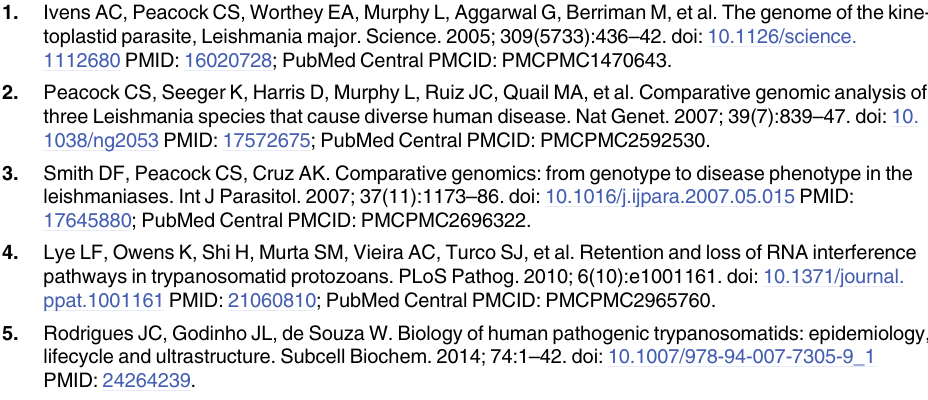
the parasitophorous vacuole membranes. Transmission electron microscopy of macrophages infected with WT L . braziliensis (WT) and two cloned cell lines expressing amastin siRNA, RNAi-1060 cl1 and RNAi-1060 cl5. Note the tight contact between the amastigotes and PV membranes in WT parasites and a greater distance between the parasite and the PV membrane in macrophages infected with RNAi knockdown parasites. S1 Table. Differentially expressed amastin genes between WT amastigotes and RNAi knockdown